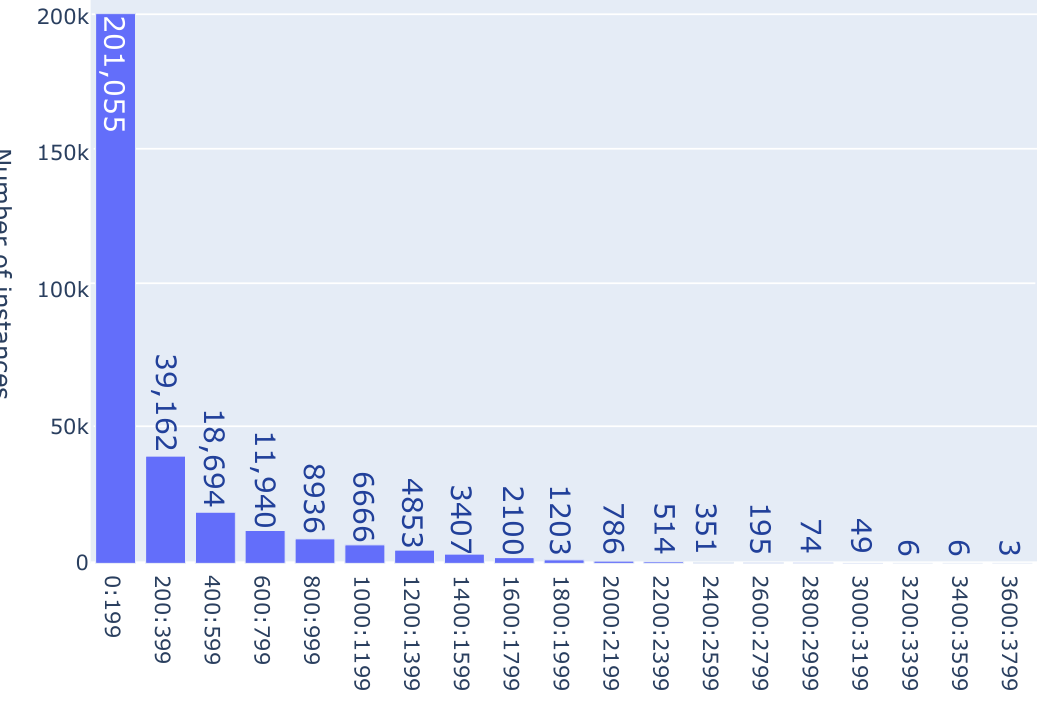
Figure 4. Number of branching points for the instances with 7 jobs.